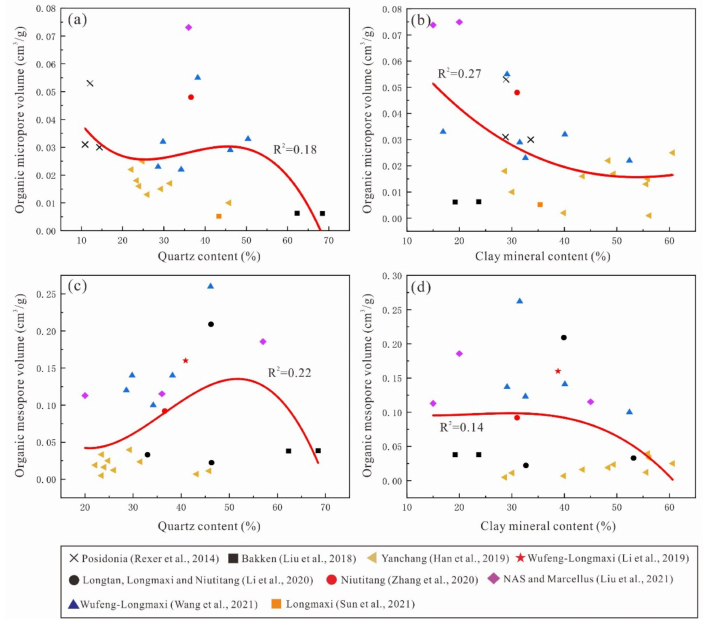
Figure 8. Cross-plots of ( a ) quartz content versus micropore volume, ( b ) clay content versus micropore volume, ( c ) quartz content versus mesopore volume, and ( d ) clay content versus mesopore volume of shale samples. Data from